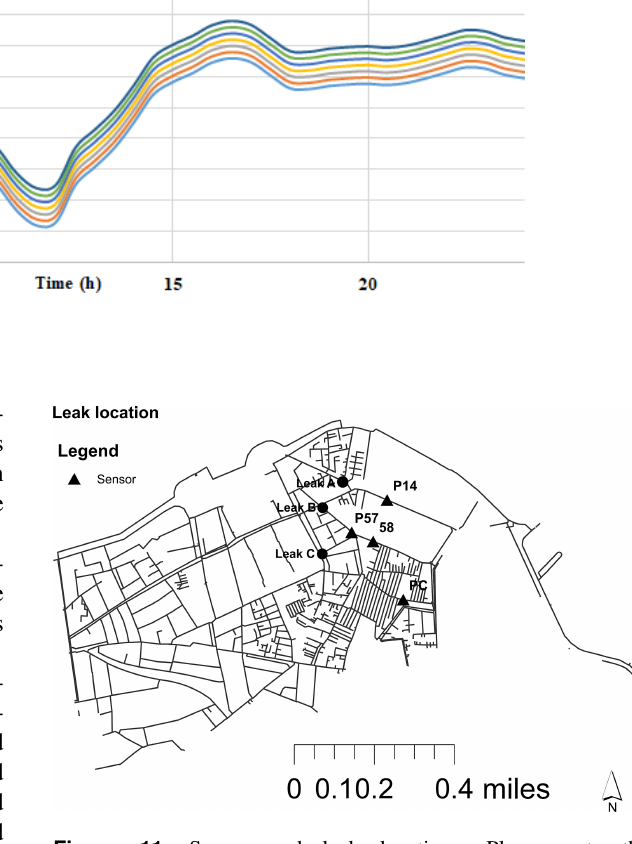
Figure 11. Sensor and leak locations. Please note that 1mi =